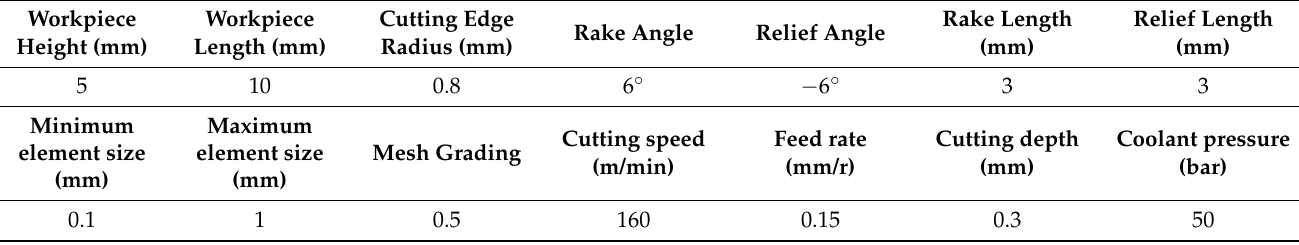
Table 1. Simulation